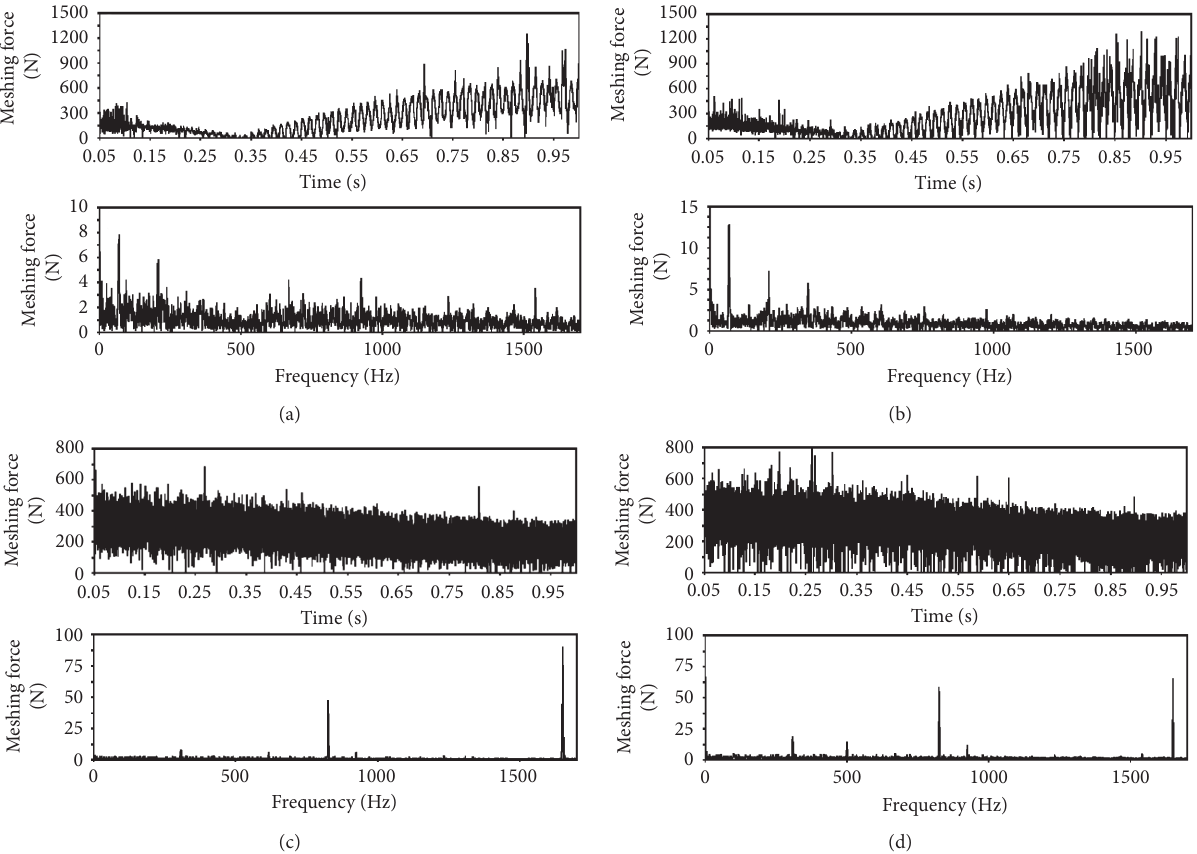
Figure 15: The time-frequency characteristics of the meshing force. (a) Sun gear and planet gear of front row. (b) Ring gear and planet gear of front row. (c) Sun gear and planet gear of rear row. (d) Ring gear and planet gear of rear row.